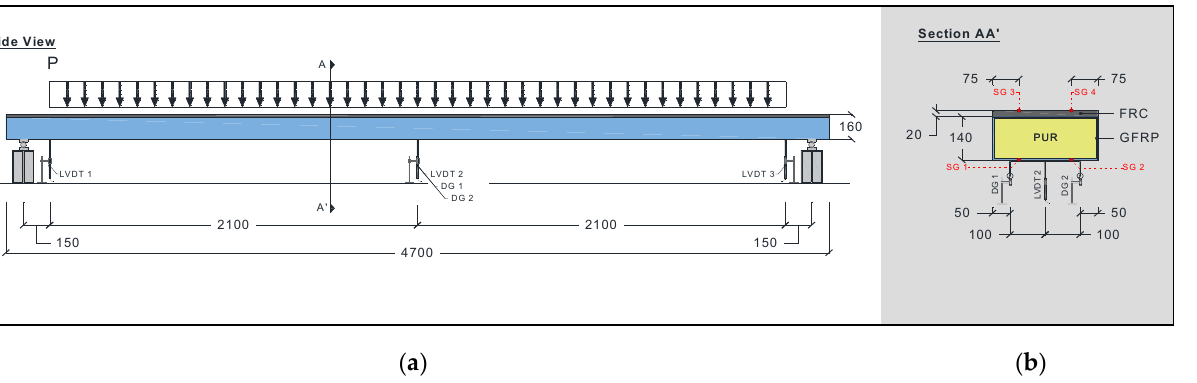
Figure 7. Geometry, test set-up and instrumentation for flexural creep tests: ( a ) side view and ( b ) cross-section view. Units in mm.